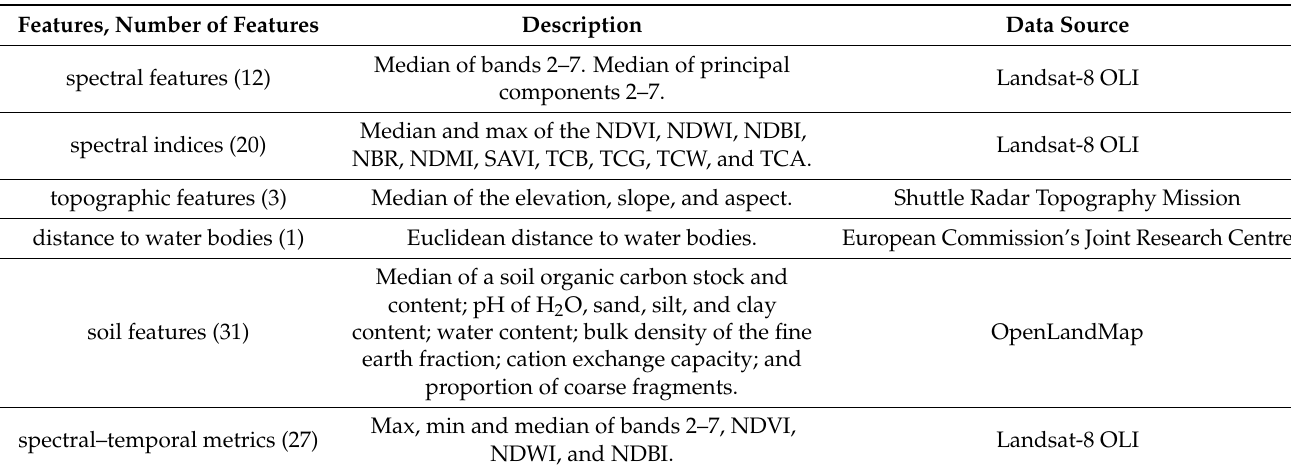
Table 2. Features in the land use/land cover (LULC)